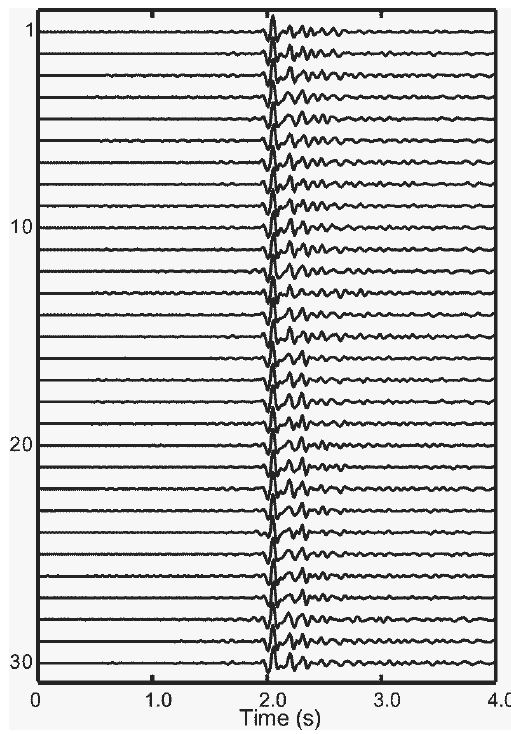
Figure 6. Example of a set of waveforms constituting a multiplet. Amplitudes are normalized to the maximum amplitude of each waveform. The vertical axis represents the number of events.